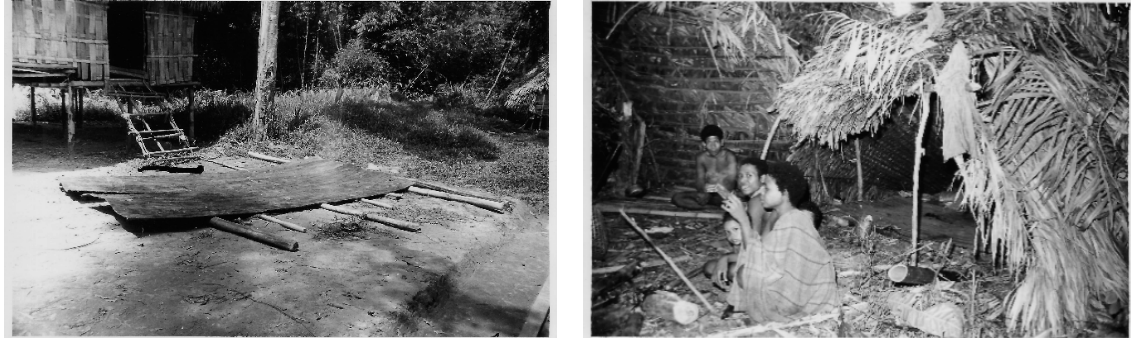
Figure 3. Bateks, Ulu Aring, Kelantan, April 1970. ( Left ) Flattened tree-bark resonator ready for a night-time song performance. ( Right ) Family in their windscreen dwelling.